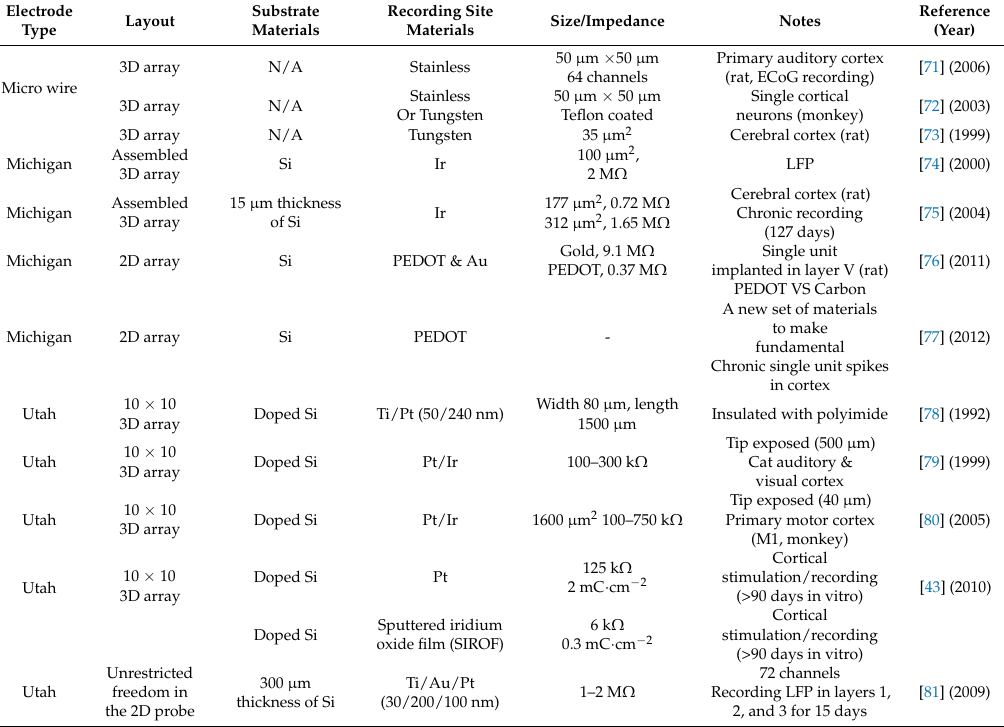
Table 2. Comparison of different penetrating electrodes with regards to various parameters. Electrode